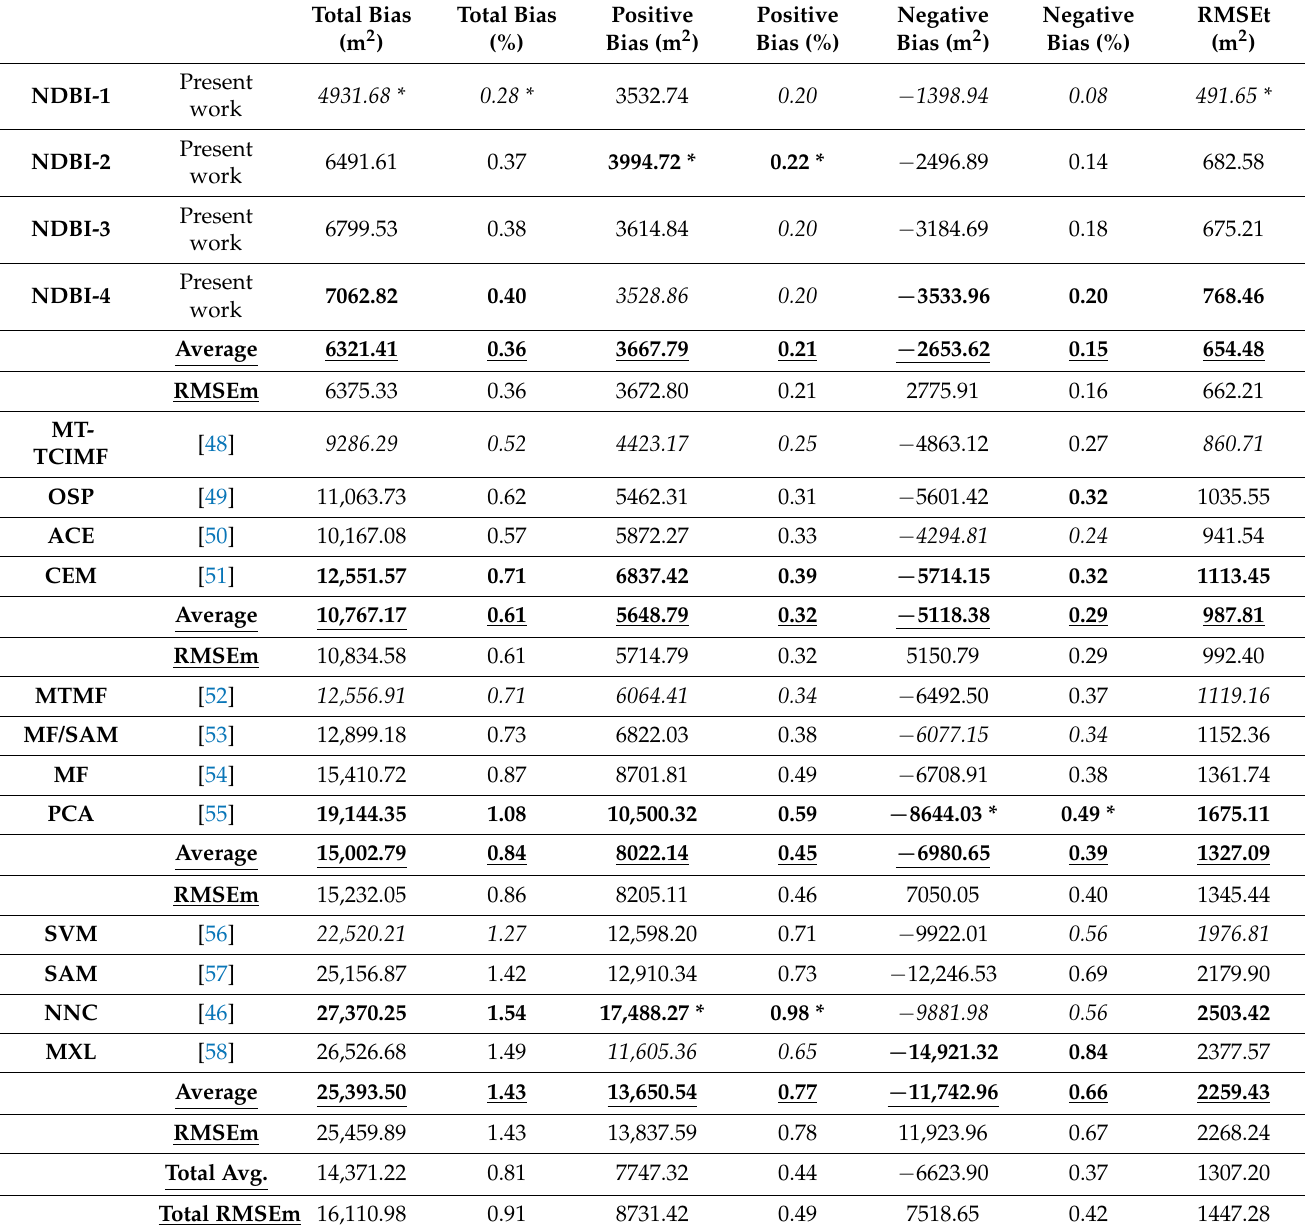
Table 5. Quantitative evaluation (bias, % and m 2 ) of various feature extraction methods for extracting blue ice from the 12 tiles analysed. The lowest (italics) and highest (bold) values in each local column are highlighted. The column-wise total and average values are bolded and underlined. Total bias represents the total misclassified blue ice area, positive bias represents the underestimated area of the total misclassified blue ice area and negative bias represents the overestimated area of the total misclassified blue ice area. Local outliers (w.r.t. four methods of the respective feature extraction approach) are highlighted with *. RMSEt refers to the error values pertaining to the 12 tiles while RMSEm refers to error values pertaining to the four methods in each respective